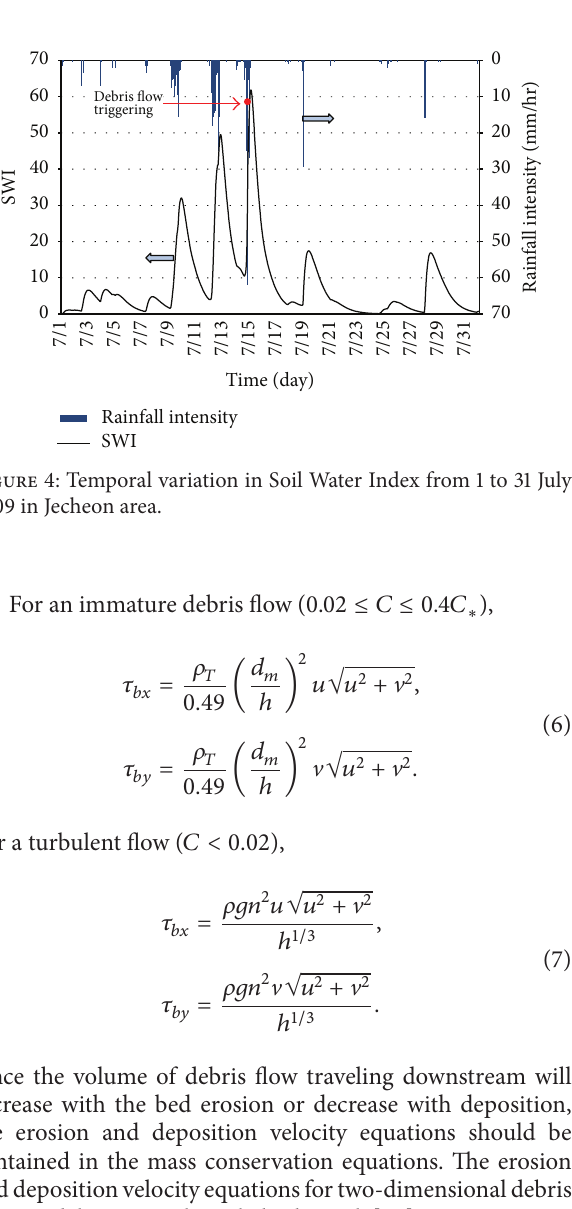
Figure 3: Rainfall at Baekun weather station on 7–16 July 2009.